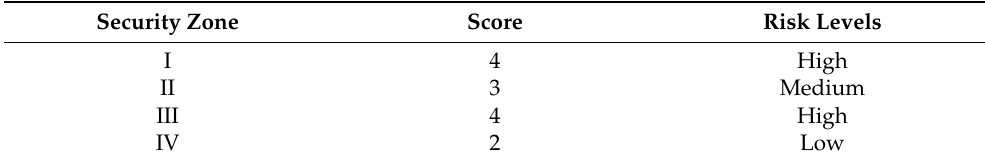
Table 1. Risk levels for each security partition. Security